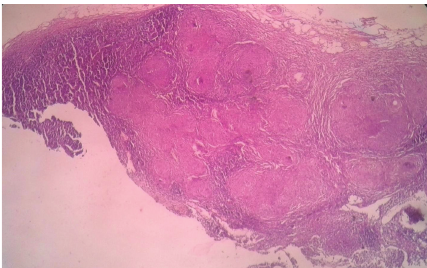
Figure 3: Histopathological examination of mesenteric lymph node with multiple granulomas at low power.